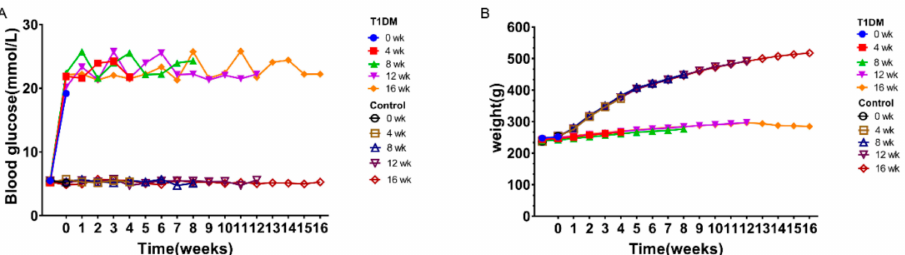
Figure 1. Weekly blood glucose and weight measurements of the SD rats. ( A ) Weekly measurements showing that the blood glucose level of all rats in the T1DM group was ≥ 16.7 mmol/L, which was obviously higher than the control group. ( B ) Weekly weight measurement showing that weight of all rats in the T1DM group was not significantly changed, but increased gradually in the control group.